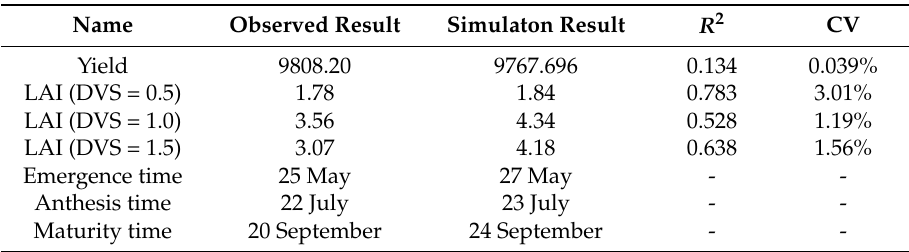
Table 8. Analysis results of the calibrated WOFOST model in 2014